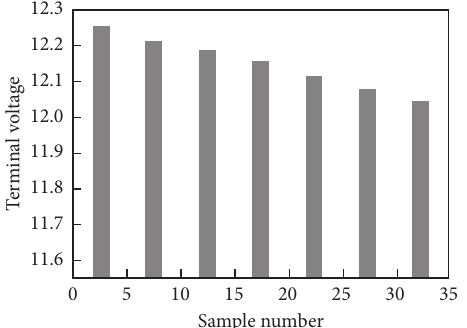
Figure 12: Terminal voltage measurement.